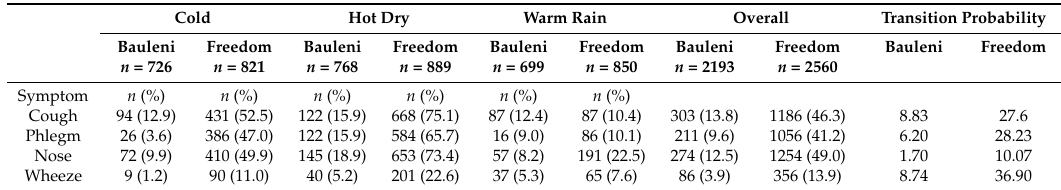
Table 3. Symptoms incidence rate (per 100 person-days) by season and community; and transition